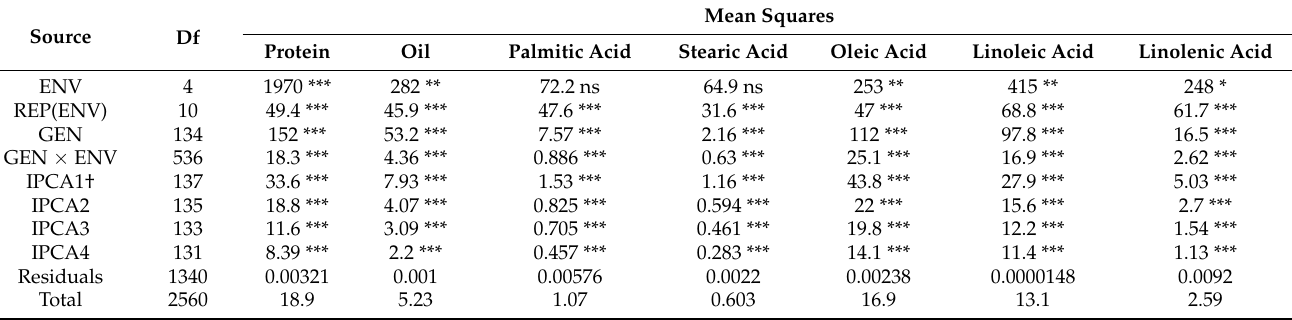
Table 2. Additive main effect and multiplicative interaction (AMMI) analysis of variance for seven seed components for 135 soybean genotypes evaluated in five